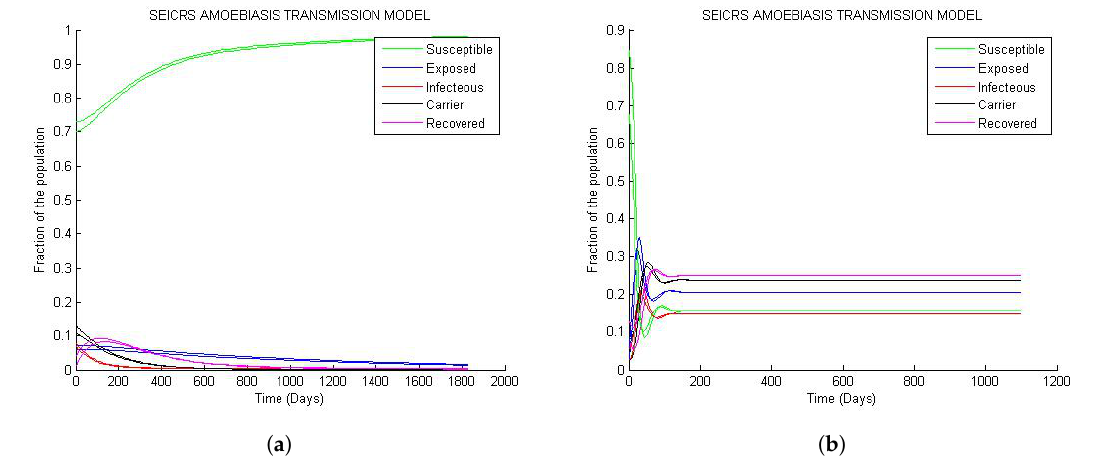
Figure 4. Asymptotic stability of the steady states: ( a ) Asymptotic stability of DFE; ( b ) asymptotic stability of the endemic